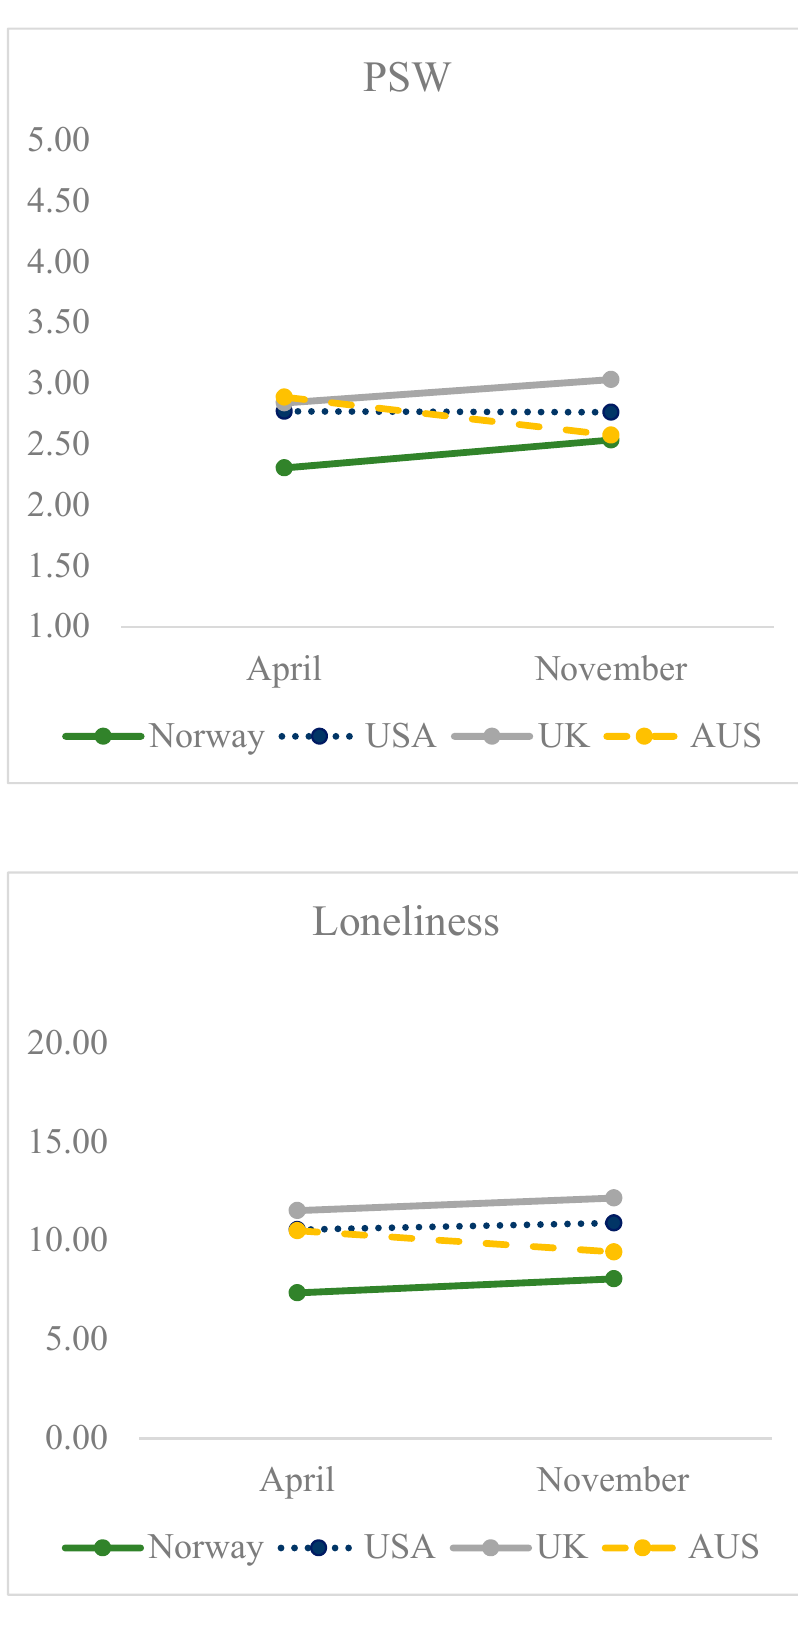
Figure 1. Adjusted means. See Section 2.3.2. Mental health, quality of life, well-being and loneliness in the measurement units used.